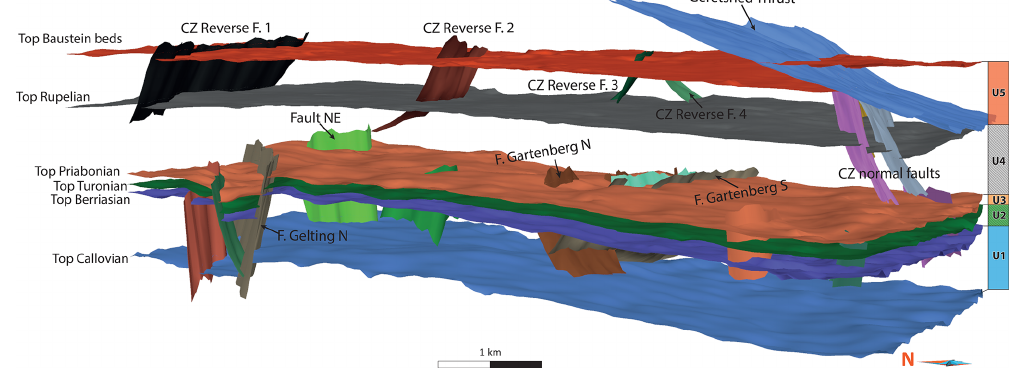
Figure 4. Oblique WSW view of the 3-D structural model showing two distinct fault arrays. The faults we refer to in this work are named.